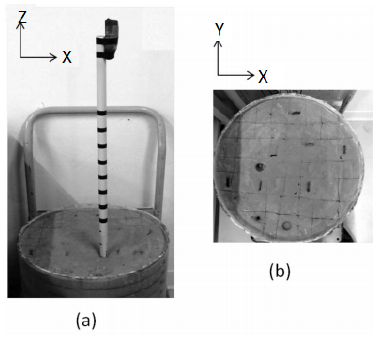
Figure 2. Photographs of ( a ) laboratory setup in clayey soil; ( b ) plastic deformation of the